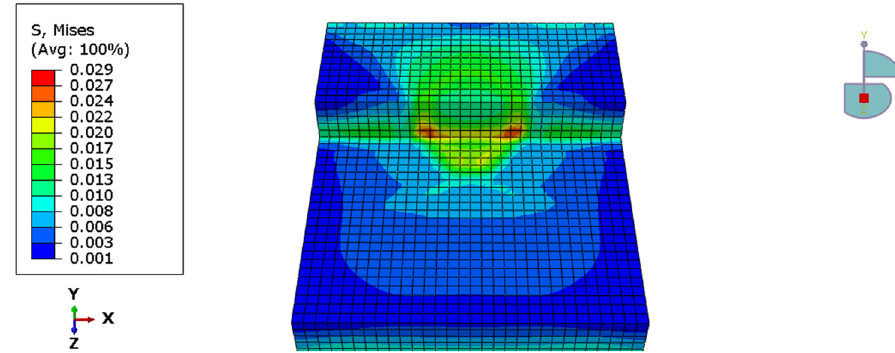
Figure 19: Stress distribution on soil behind thrust block ( MPa ) .